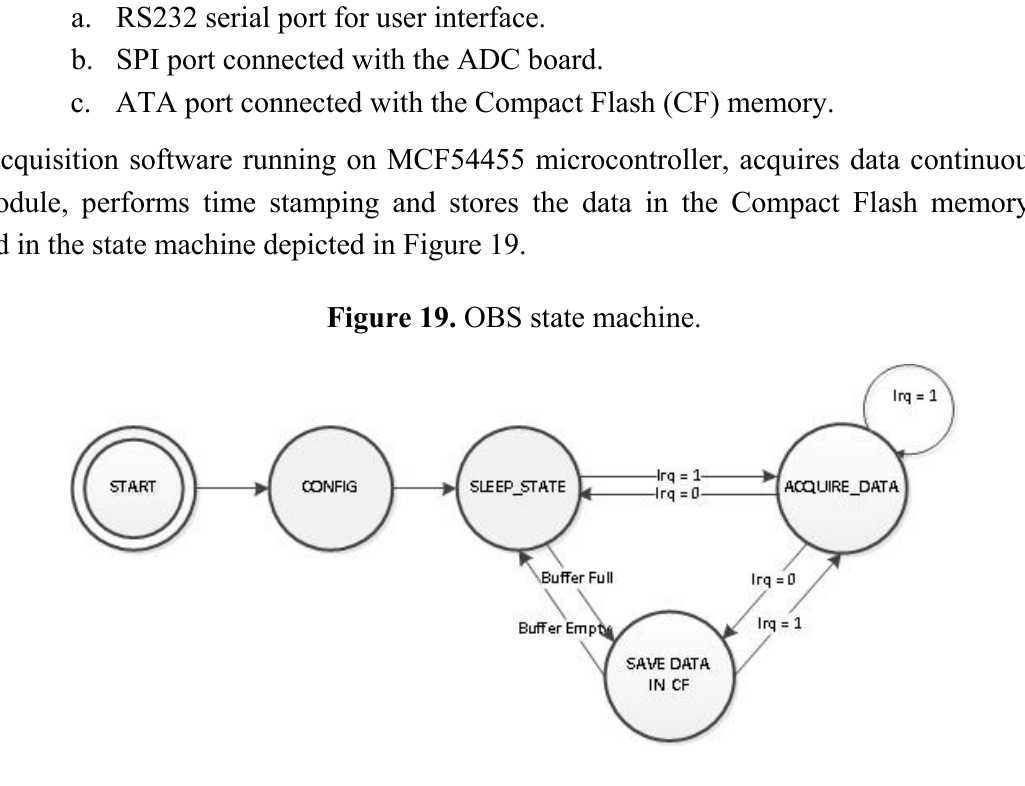
Figure 20. Power circuit schema of the 3.3 V for microcontroller